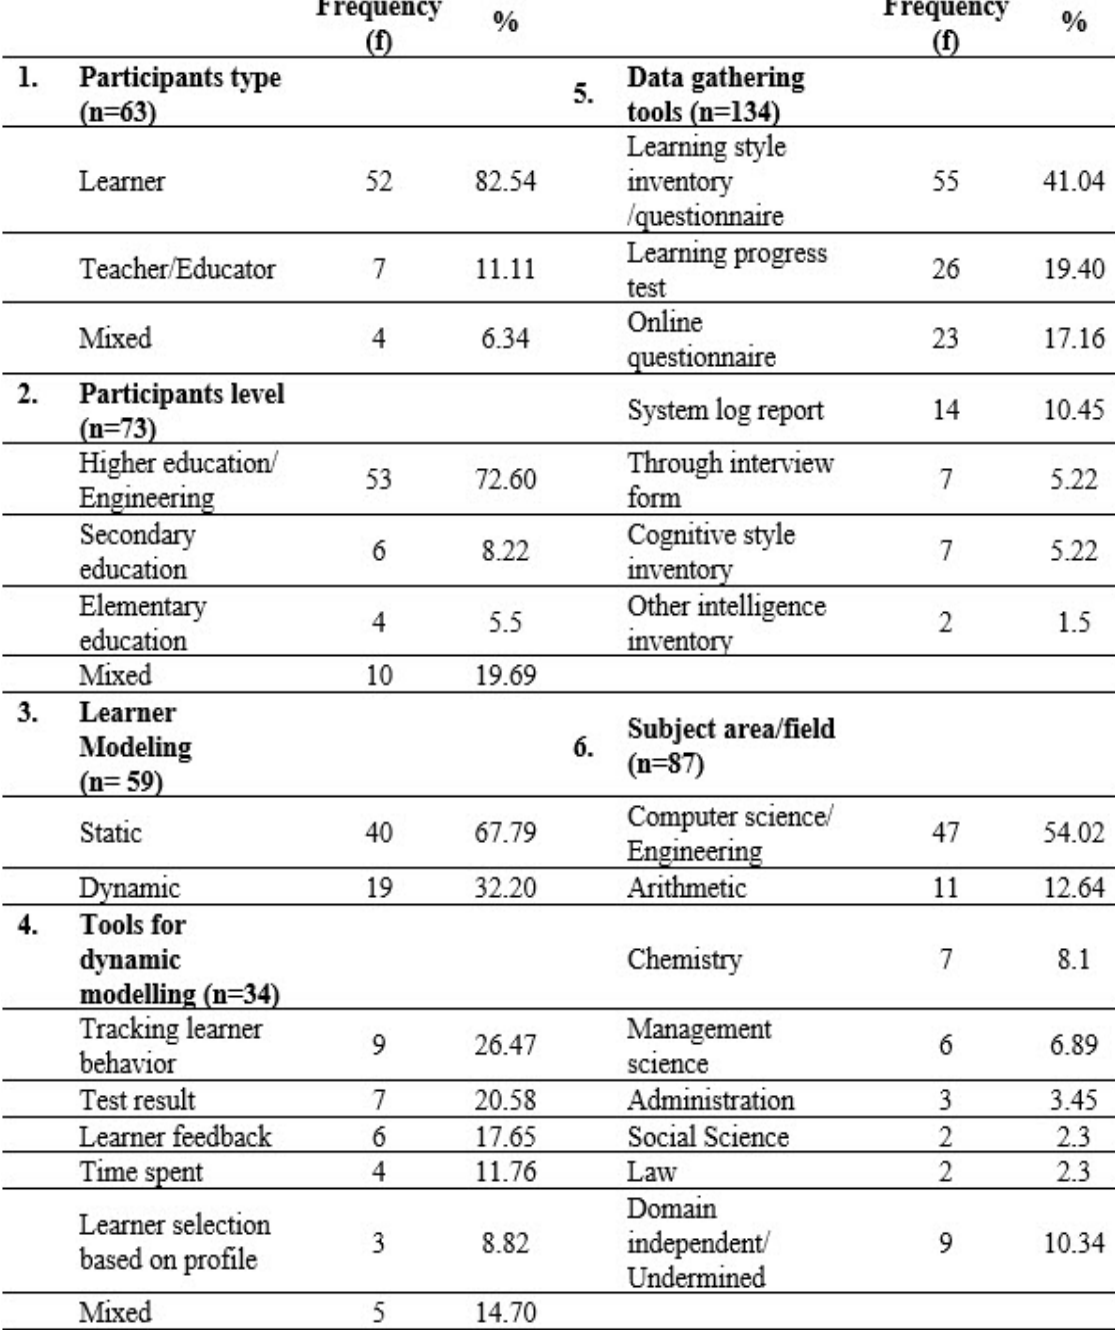
Table 2. Summary of participant’s type and their levels, learning modelling/tools, subject area/field, and data gathering